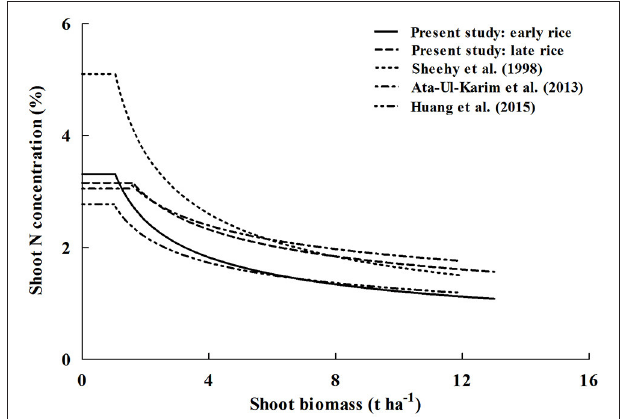
FIGURE 7 | Comparison of different N c dilution curves in rice. The (____) line represents N c curve of early rice in this study (N c = 3.37 W − 0.44 ), the (__ __) line represents N c curve of late rice in this study (N c = 3.69 W − 0.34 ), the (......) line represents N c curve of Indica rice of Sheehy et al. (1998) (N c = 5.20 W − 0.45 ), the (__ . __ ) line is for Japonica rice in Yangtze River reaches of Ata-Ul-Karim et al. (2013) (Nc = 3.53 W − 0.28 ), the (__ . . .) line is for Japonica